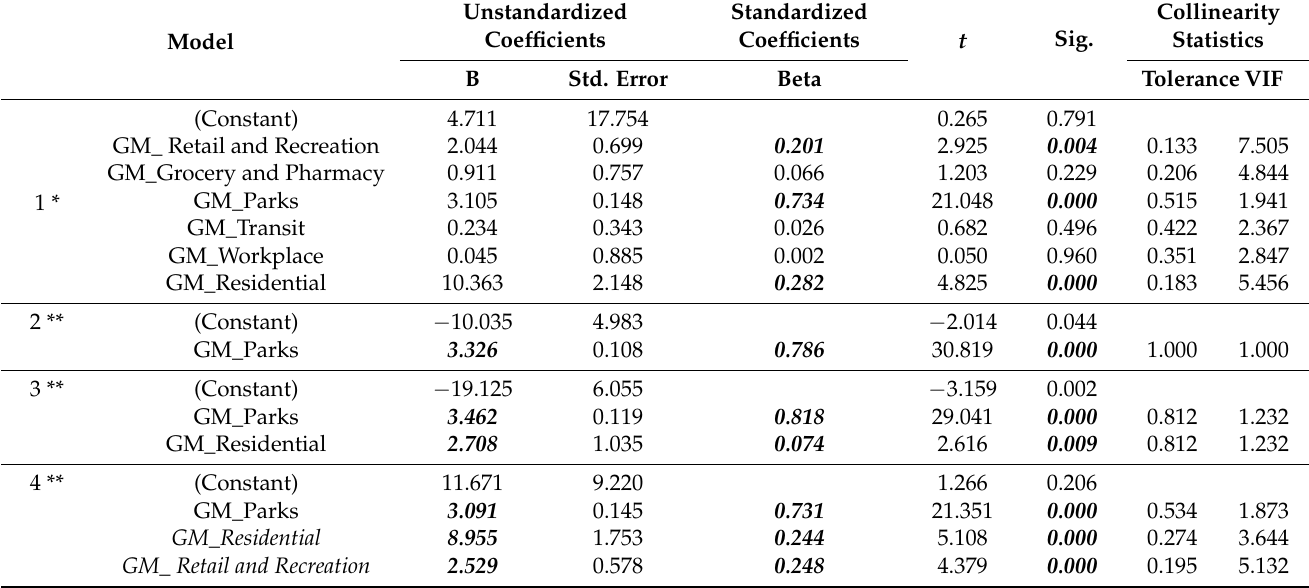
Table 4. Coefficients for Models